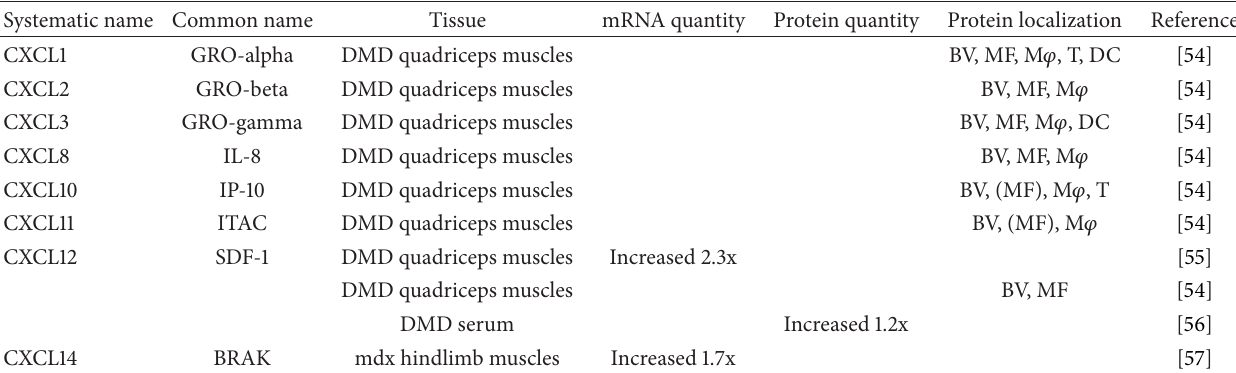
Table 1: Alpha-chemokine expression in Duchenne muscular dystrophy and its mouse model.